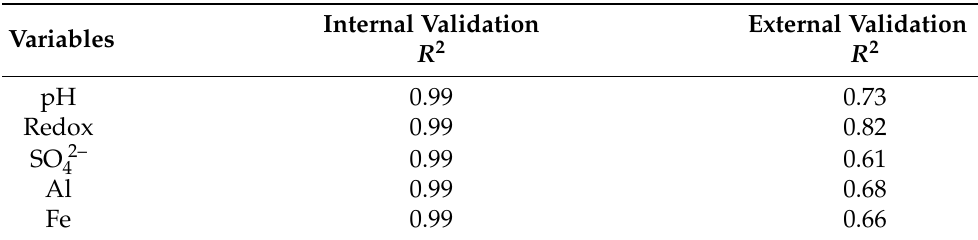
Table 3. R 2 values after regression are given for each variable predicted in the obtained surface wa- ter